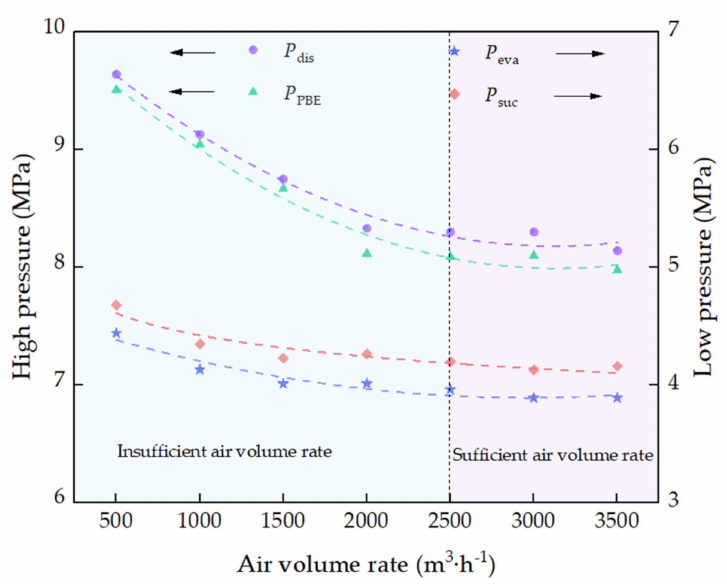
Figure 3. Effect of the air volume flow rate in the gas cooler on the pressures of the investigated system.